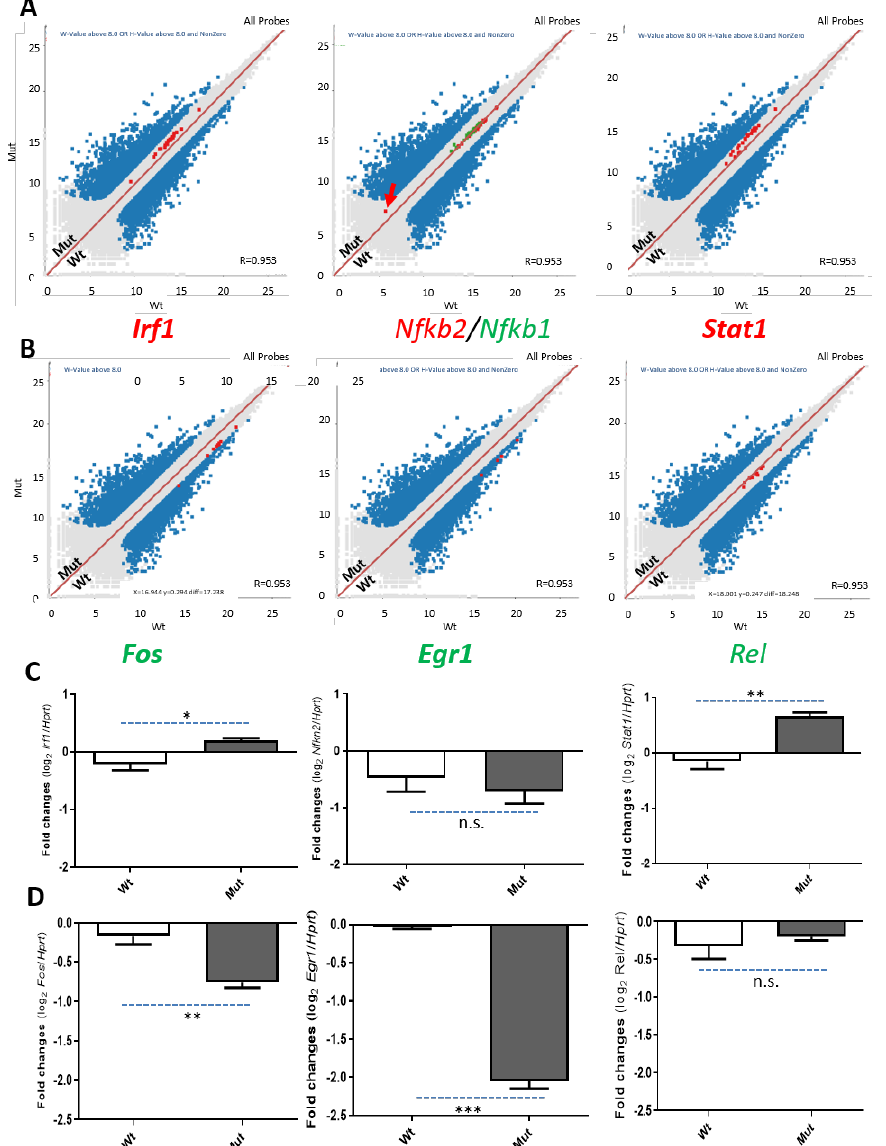
Figure 6. The NF- κ B pathway is the link between the effects of the loss of TSPO on mitochondria and changes in nuclear gene expression. ( A ). Up-regulation of three genes involved in the NF- κ B pathway: Irf1 , interferon regulatory factor 1, and the whole set of Irf1 exons are up-regulated as an early actin-rearrangement-inducing factor gene; Nfkb2/1, nuclear factor kappa B subunit 2/1, and one of the Nfkb1 exons (exon 1, indicated in red arrow) are dramatically up-regulated, indicating there is an isoform-specific change; and Stat1, signal transducer and activator of transcription 1, and all of the Stat1 exons are up-regulated as a whole gene. ( B ). Down-regulation of three genes involved in the NF- κ B pathway: Fos , a proto-oncogene, AP-1 transcription factor subunit (with Jun); Egr1 , early growth response protein 1; and Rel , REL proto-oncogene and NF- κ B subunit. All of the genes from the NF- κ B signaling pathways were selected from the NF- κ B Signaling Pathway RT2 Profiler™ PCR Array PAMM-025Z (Qiagen, Germantown, MD, USA). ( C , D ). Real-time PCR of the six genes shown in A and B. Both Irf1 and Stat1 up-regulation and Fos and Egr1 down-regulation in Tspo Mut cells were confirmed. n.s., non-significant; * p < 0.05, ** p < 0.01, and *** p < 0.001; Student’s t -tests ( n =